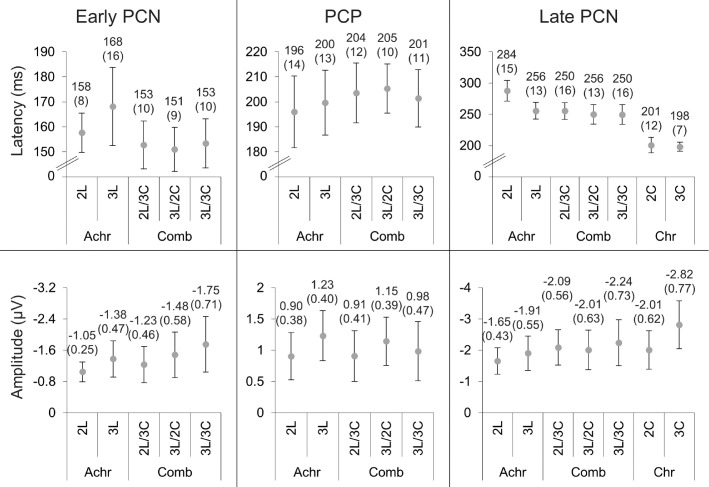
The latencies (top) and amplitudes (bottom) of the early PCN, PCP, and late PCN (left to right) detected in Experiment 2. The means and 2 standard errors (in brackets) are above each data point. The units are milliseconds and microvolts for the latencies and amplitudes, respectively.